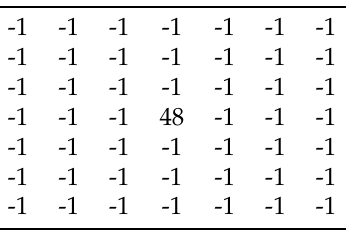
Table 1. 7 7 Laplacian approximation ×